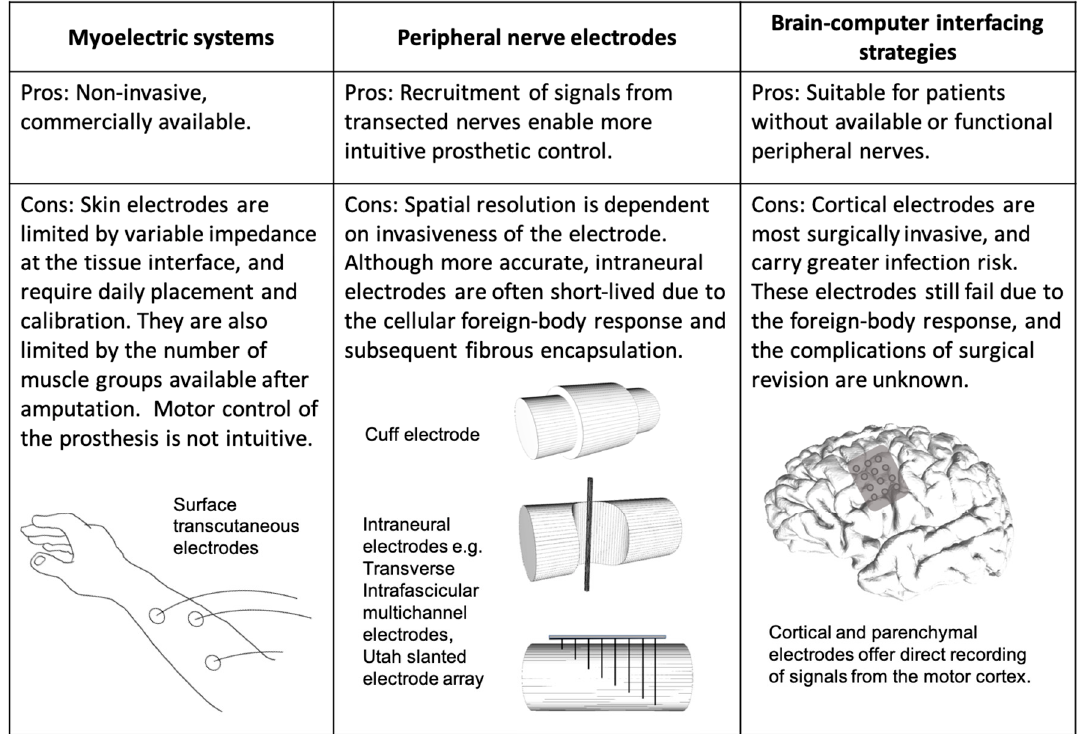
Figure 1. Di ff erent methods of achieving mind-control of motorised prosthetic Figure 1. Different methods of achieving mind-control of motorised prosthetic limbs.